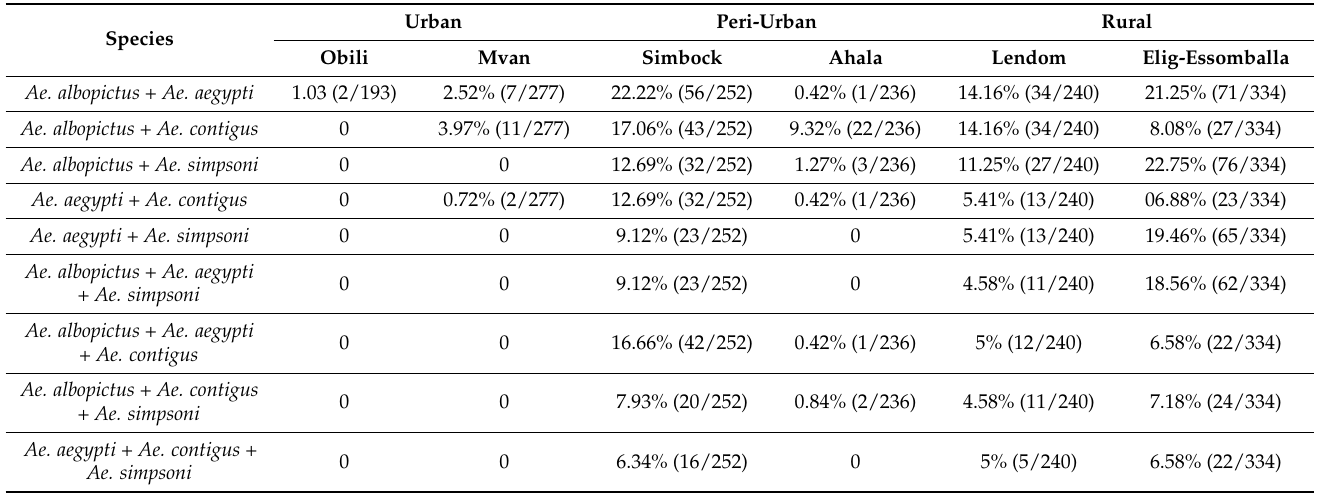
Table 4. Aedes species cohabitating in ovitraps.